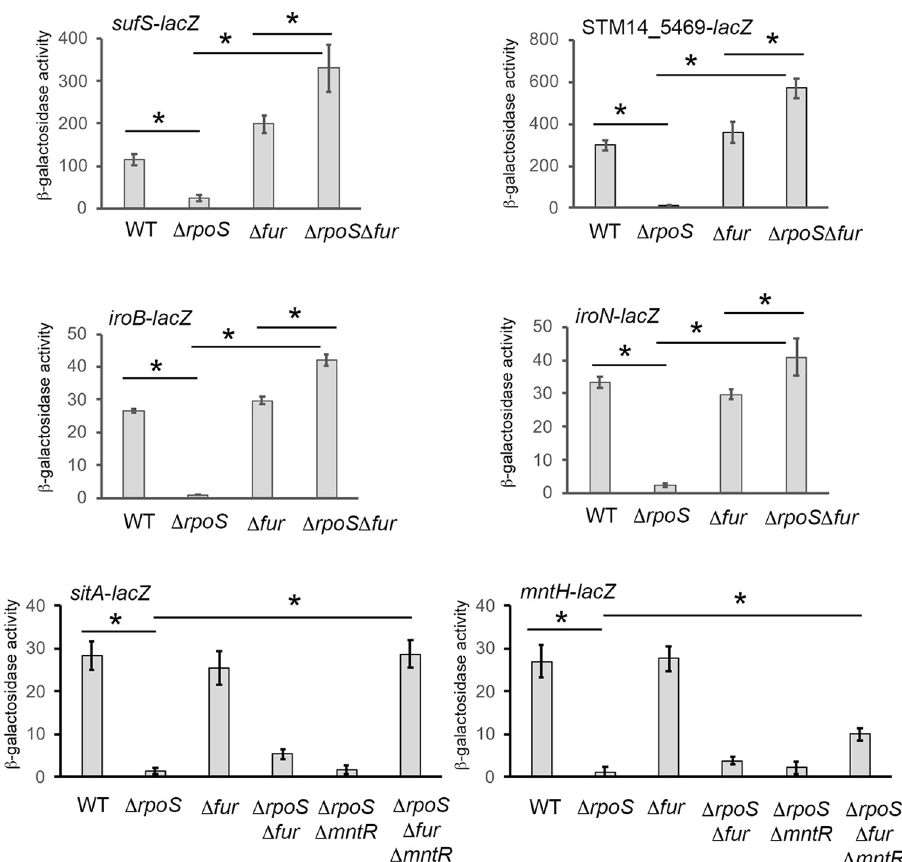
Fig 4. σ S alleviates repression of genes involved in iron and manganese metabolism. Expression of the indicated lacZ fusions was assessed in the wild type Δ rpoS , Δ fur and Δ r poS Δ fur strains grown for 18 h in LB at 37˚C. For the sitA- lacZ and mntH-lacZ fusions, effect of the Δ mntR mutation was also determined. Bar graphs represent the mean β - galactosidase activity, and error bars represent standard error of the mean of at least three independent experiments ( � p <